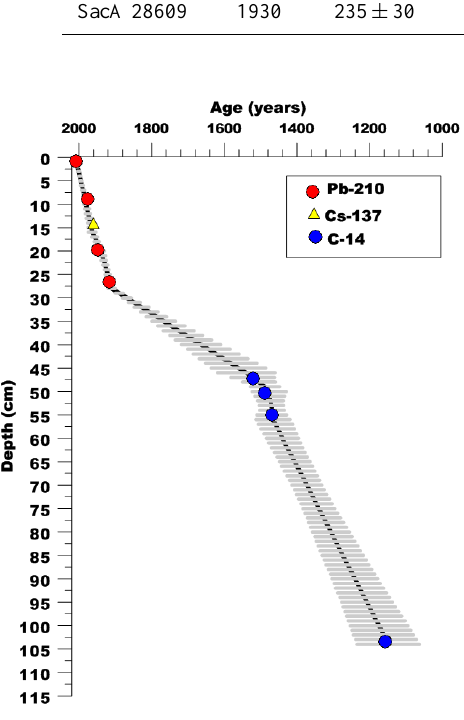
Figure 5. Stratigraphic age-depth plot of the MC45 core undertaken in the clam code package (Blaauw, 2010). Clam settings: linear in- terpolation; 1000 iterations weighted by calibrated probabilities at 95% confidence ranges and resolution 1 year steps. Clam output statistics: 0–104cm with age reversals were removed.